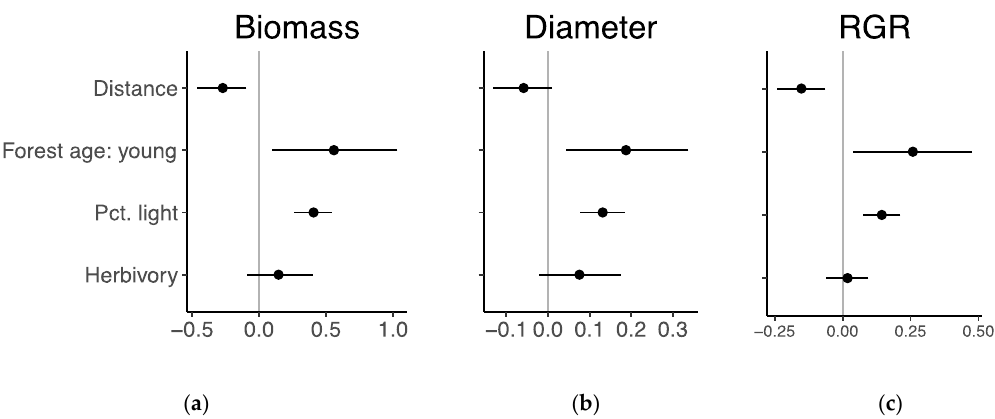
Figure 6. Coefficient estimates ±95% confidence intervals of scaled coefficients for distance, forest successional age, percent available light, and herbivory across all species from mixed-effects regression models fit to ( a ) biomass, ( b ) diameter, and ( c ) relative growth rate of height (RGR).